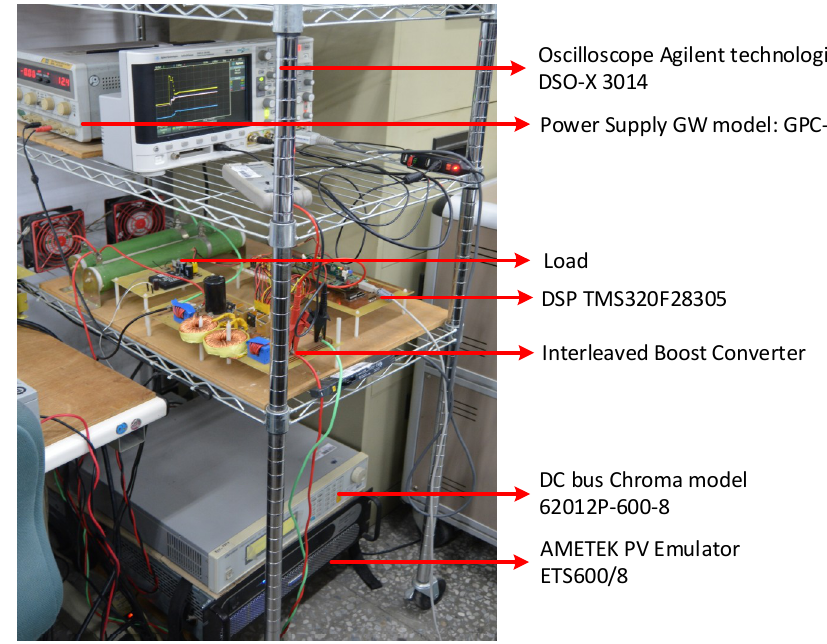
Figure 10. The experimental setup equipment.